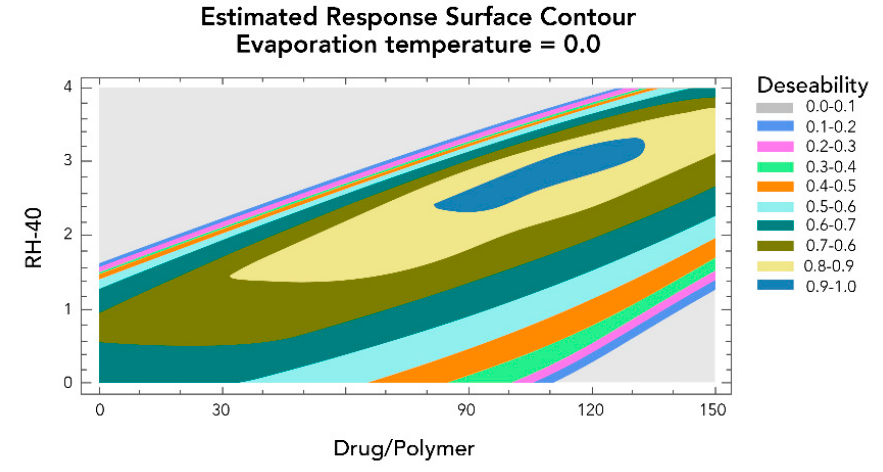
Figure 8. Response surface plot for the development of nanoparticles of 50 nm in diameter.